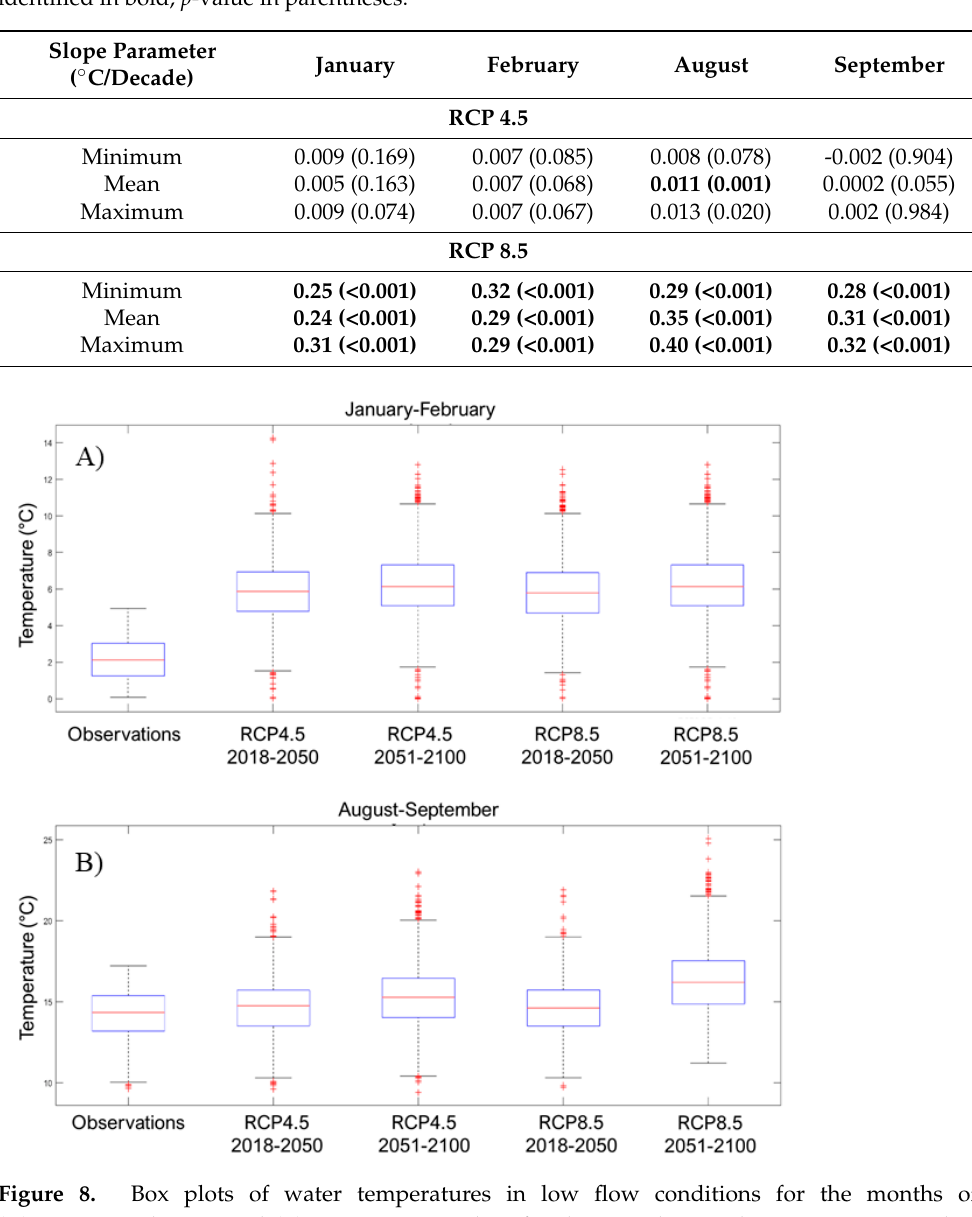
Table 4. Slope over time ( ◦ C/decades) for mean, minimum and maximum monthly simulated temperatures for Scenarios RCP 4.5 and RCP 8.5. Significant trends for temperature change are identified in bold, p -value in parentheses.